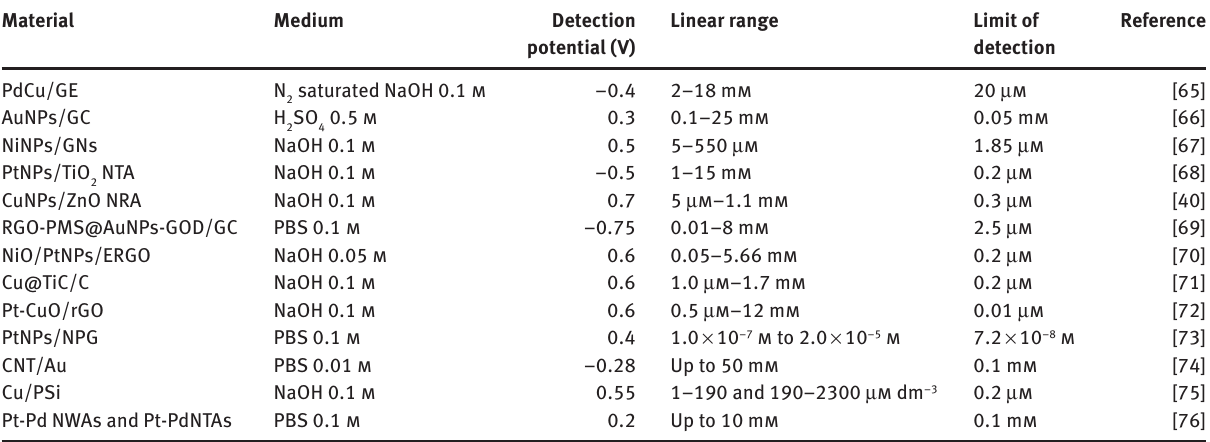
Table 2: Various noble MNP-modified materials that have been used in enzyme-free glucose biosensors.